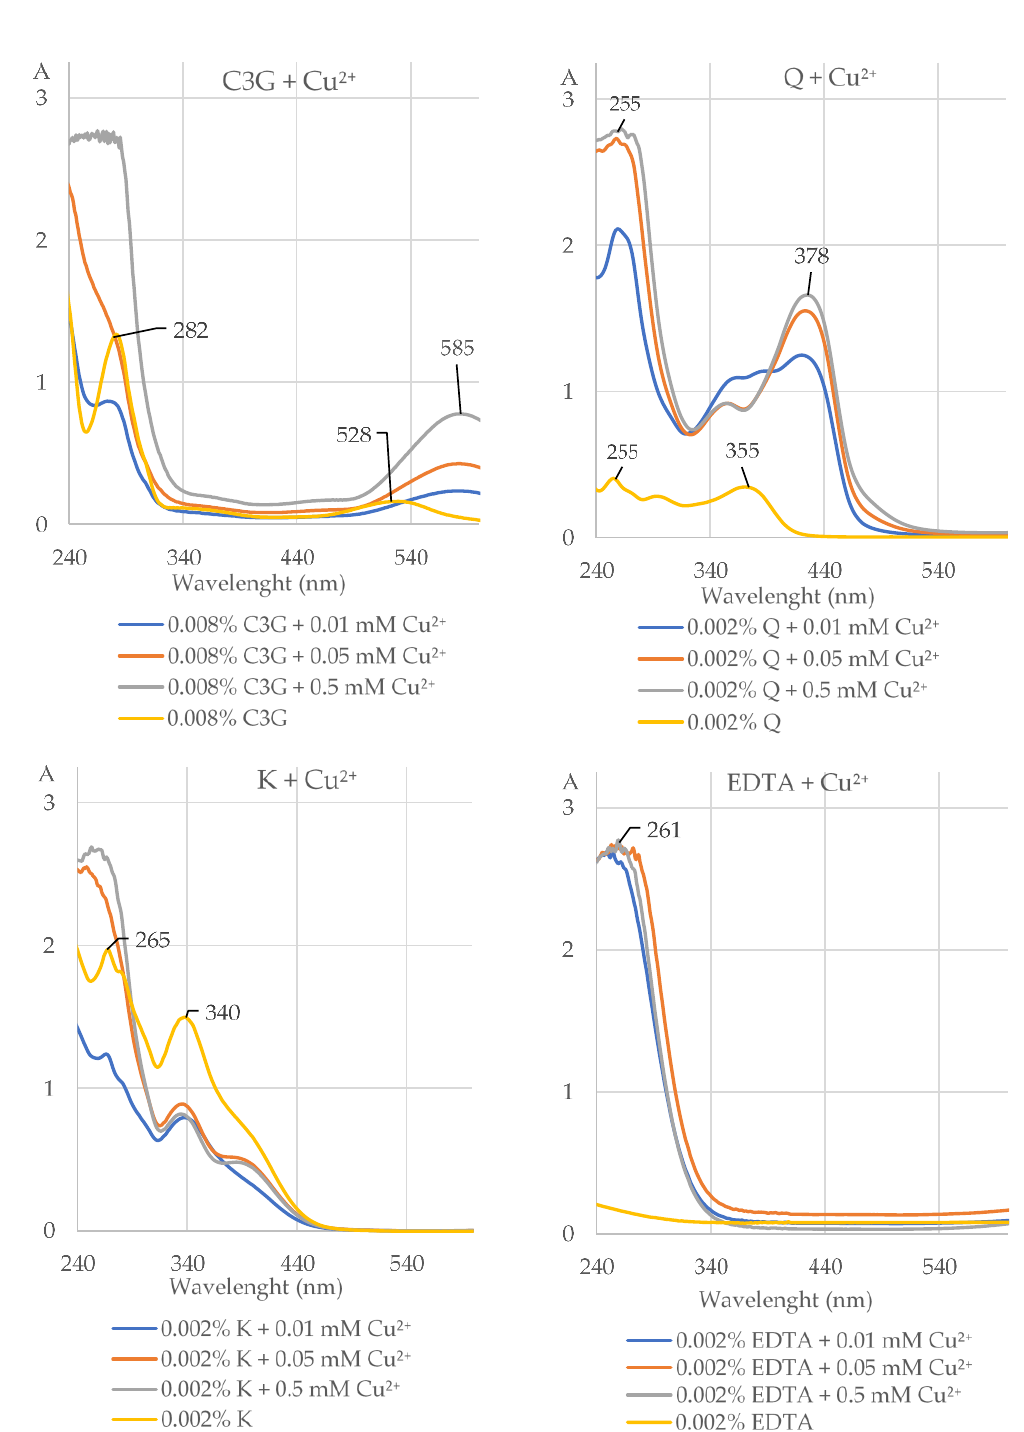
Figure 3. The UV–Vis absorption spectra (with indicated maximum absorption) of the extract from Aronia melanocarpa L. berries (0.05% and 0.1% AE) alone and after addition of divalent ions of copper (Cu 2+ ) at the concentrations of 0.01, 0.05, and 0.5 mM at pH 5.5. The shift of the maximum absorption after addition of Cu 2+ to the AE indicates that the extract chelated these ions. A, absorbance.